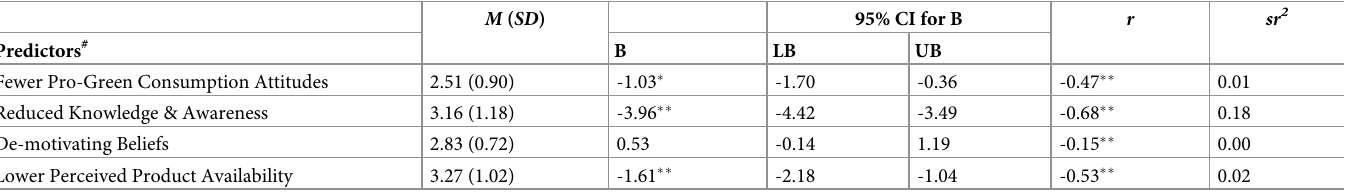
M = mean, SD = standard deviation, B = unstandardised beta, CI = confidence interval, LB = lower bound, UB = upper bound, r = correlation coefficient, sr 2 = squared semipartial correlation coefficient. # All predictors have been scored as